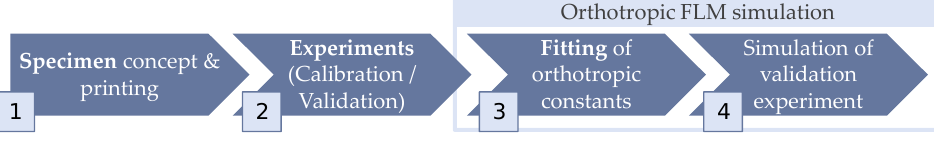
Figure 2. Overarching methodology of this contribution.